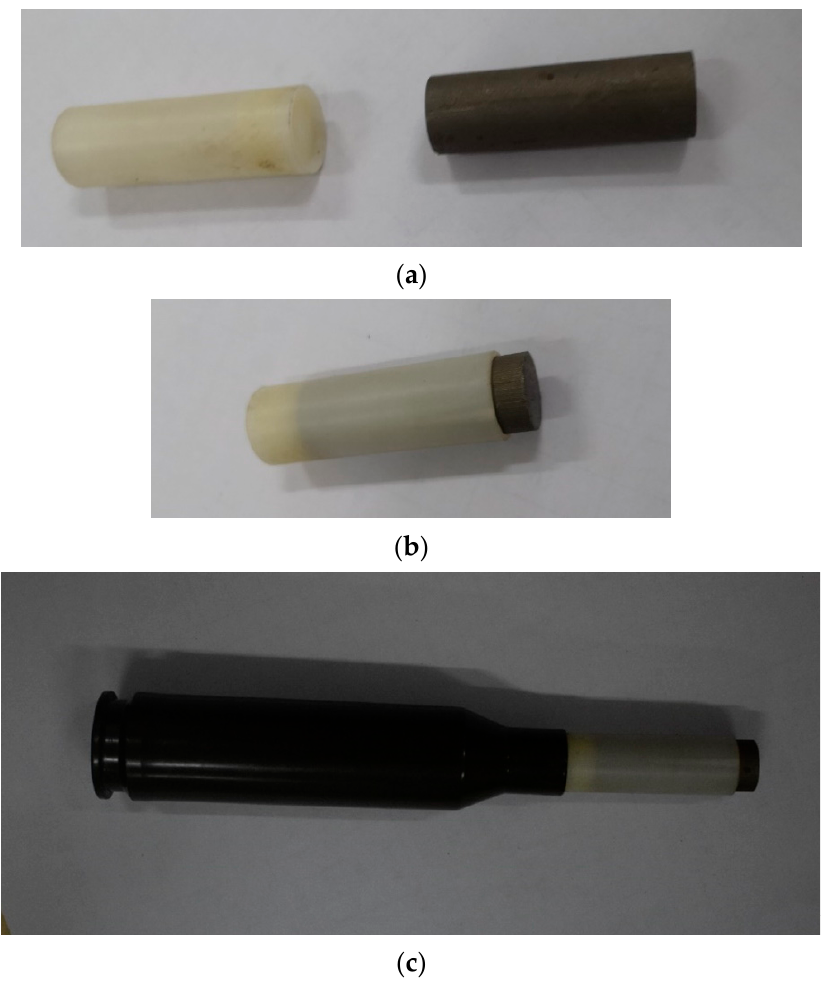
Figure 6. Photograph of the projectile in the test. ( a ) The projectile and sabot. ( b ) Assembly of the projectile in the sabot. ( c ) Assembly of the projectile in the shell case.